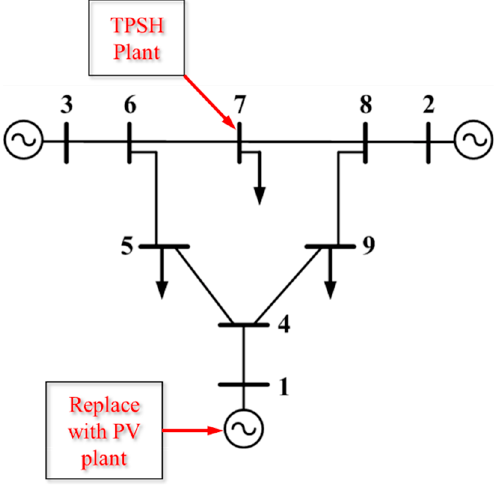
Figure 4. IEEE 9-bus test system indicating PV and PSH